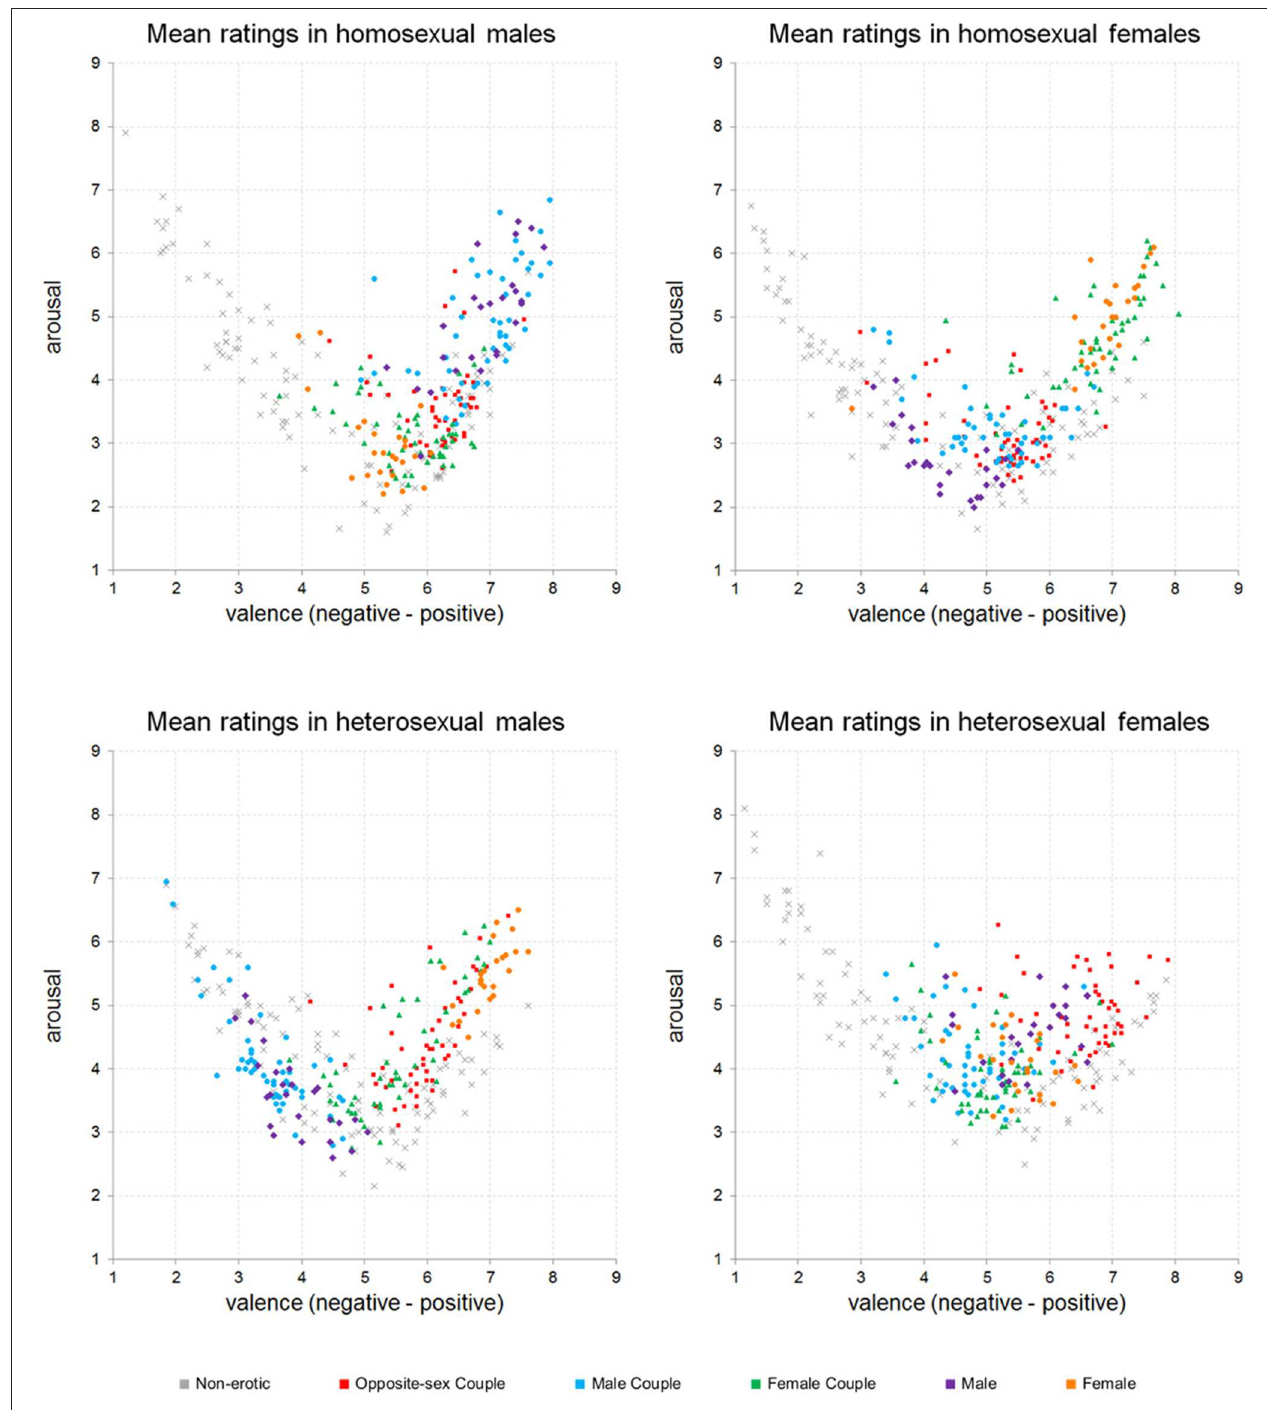
FIGURE 2 | Distribution of the mean ratings obtained for 200 erotic images from NAPS ERO and 100 control non-erotic images from NAPS in the affective space of valence and arousal. Each plot represents mean ratings obtained from a different group of participants.